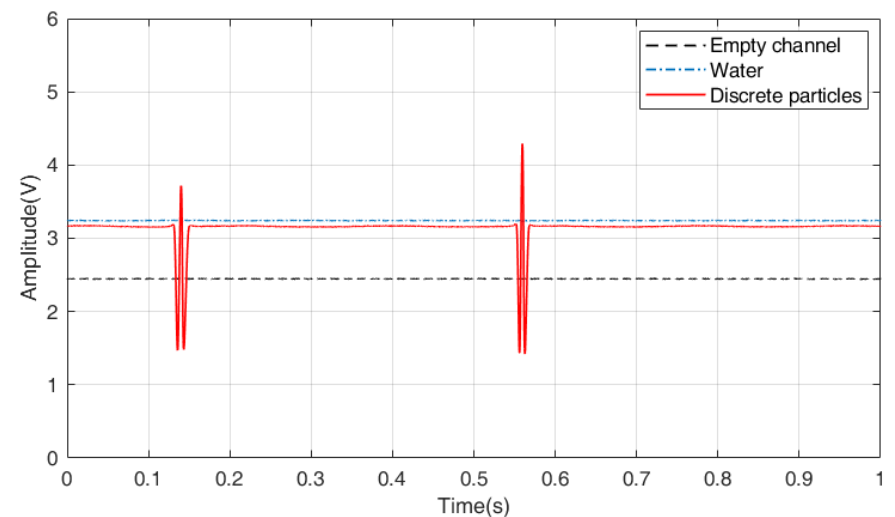
Figure 2. Optical signals of different flow conditions.